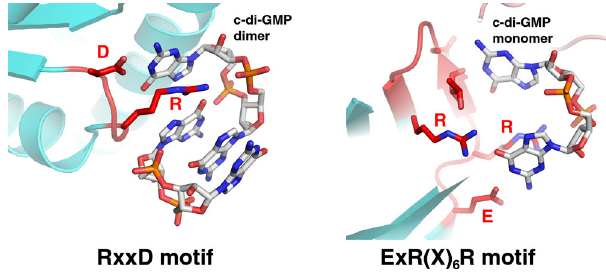
Fig. 8 | Comparison of c-di-GMP bound to a canonical RxxD motif (left) in the PelD-c-di-GMP complex (4DN0: https://www.rcsb.org/structure/4dn0) to the RxxD containing region in the S. venezuelae GlgX-c-di-GMP complex (right). The arginine and aspartic acid of the PelD RxxD motif speci fi es two bases of a boundc-di-GMPintercalateddimer.Bycontrast,theguaninebasesofthec-di-GMP bound to GlgX are speci fi ed by residues outside the arginine and aspartic acid of the GlgX RxxD region, speci fi cally the fi rst glutamic acid and last arginine in the GlgX ExR(X) 6 R motif as well as main chain